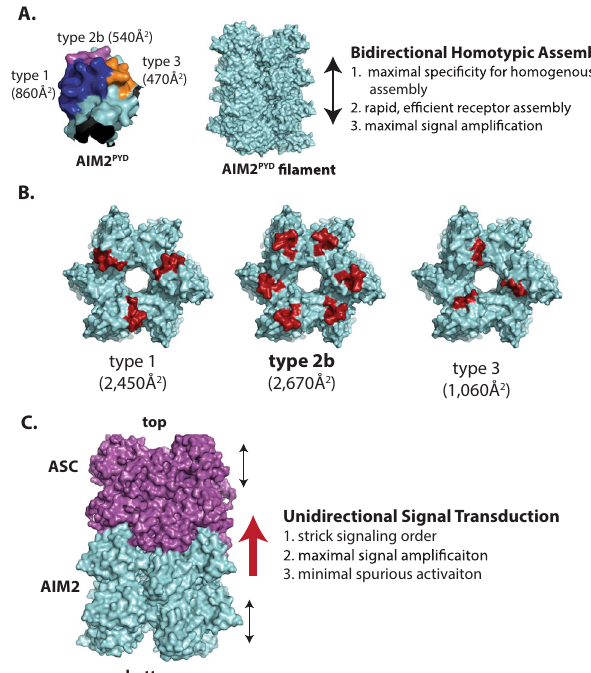
Fig. 6 Strategies for signal transduction by the AIM2-ASC in fl ammasome. A Left: a surface representation of AIM2 PYD monomer. The buried surface area in the fi lament for each interface type is indicated. Right: a scheme describing the advantages of bidirectional homotypic assembly. B The top surface view of the AIM2 PYD fi lament. Each solvent accessible interface is colored in red with the calculated surface area. C A scheme describing the advantages of unidirectional signal transduction by the AIM2-ASC in fl